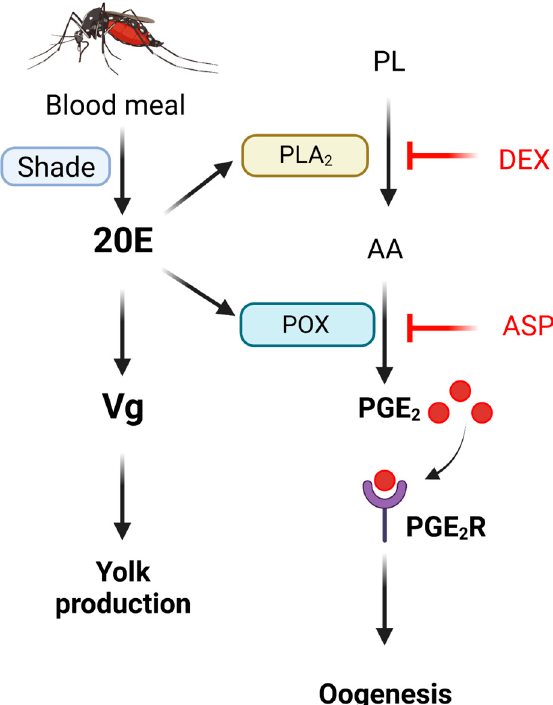
Figure 9. Working hypothesis of PGE 2 on oogenesis of Ae. albopictus . Oogenesis is stimulated by blood-feeding via an endocrine signal of 20-hydroxyecdysone (‘20E’), which is synthesized by the catalytic activity of a cytochrome P450 monooxygenase called ‘Shade’. The 20E stimulates vitellogenin (‘Vg’) synthesis in fat body to be accumulated in the growing oocytes. The 20E also stimulates PGE 2 biosynthesis in the follicles by inducing the gene expressions of ‘PLA 2 ′ and COX-like ‘POX’. PLA 2 catalyzes the release of arachidonic acid (‘AA’) from phospholipid (‘PL’). This reaction is specifically inhibited by dexamethasone (‘DEX’) treatment. COX-like POX catalyzes the oxygenation of AA to form PGE 2 . This is specifically inhibited by aspirin (‘ASP’) treatment. The formed PGE 2 then binds to its specific receptor (‘PGE 2 R’) on the ovarian membranes and mediates oogenesis. Our results propose a novel endocrine signal that uses PGs in mosquito oogenesis.